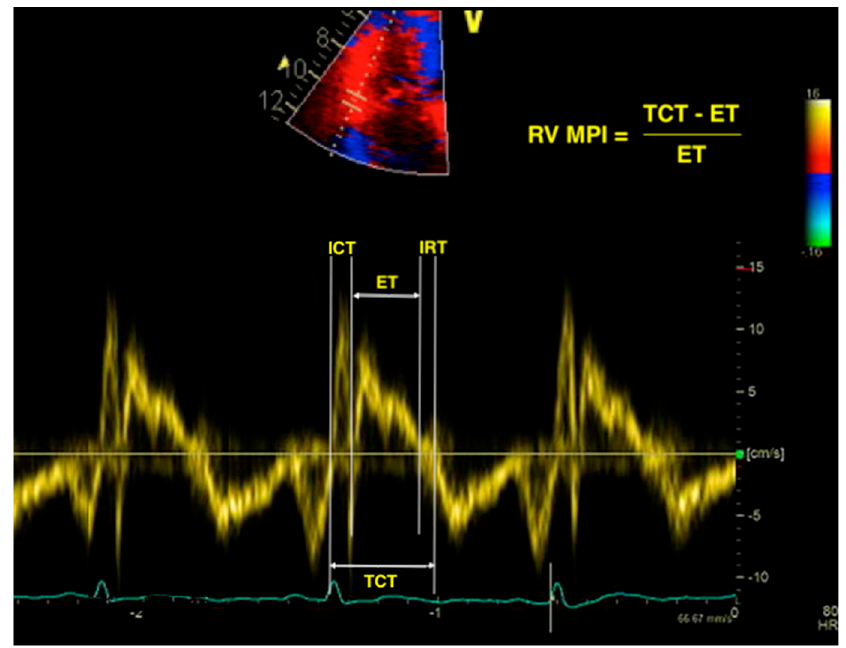
Figure 1. Calculation of right ventricular myocardial performance index (RV MPI) using the tissue Doppler imaging (TDI) method. RV—right ventricle; MPI—myocardial performance index; TDI—tissue Doppler imaging; ICT—isovolumic contraction time; ET—ejection time; IRT—isovolumic relaxation time; TCT—total contraction time.